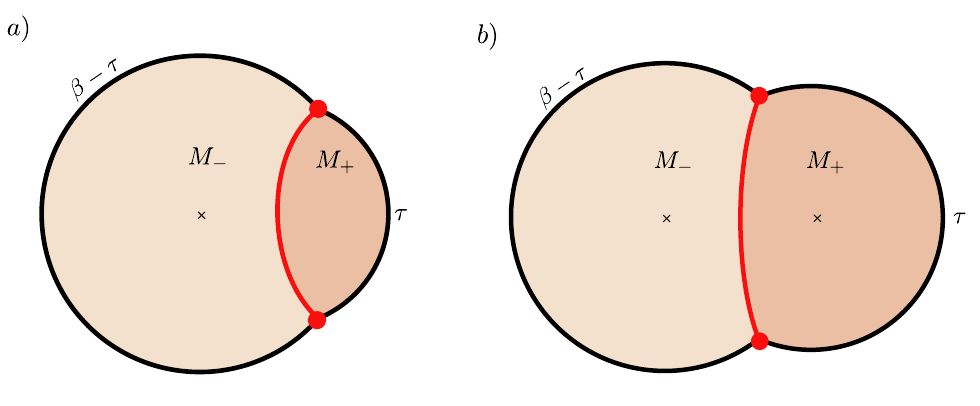
Figure 1 . Geometry of the saddlepoint manifold X for τ ∈ [0 , β/ 2] . The case a ) for τ < τ c , in which the right patch X + does not include the tip of the right disk. The case b ) for τ > τ c , in which the solution includes both